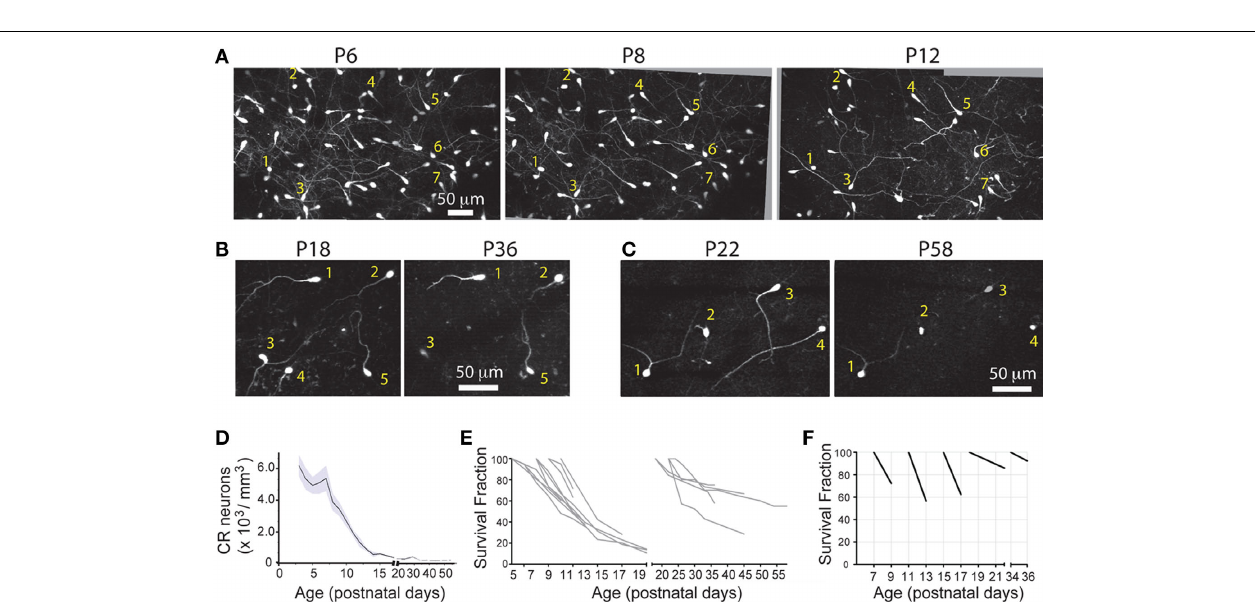
FIGURE 3 | GFP + cells in Ebf2 mice display the typical electrophysiological properties of Cajal–Retzius neurons. (A) GFP + cells in layer 1 of a P8 Ebf2 mouse were targeted for patch-clamp recordings and fi lled intracellularly with Alexa-594 (red) in acute coronal brain slices. (B) In the same slice, a GFP − cell was also targeted for recording; Inset: note that many thin dendrites (arrowheads) emanate radially from the rounder and larger